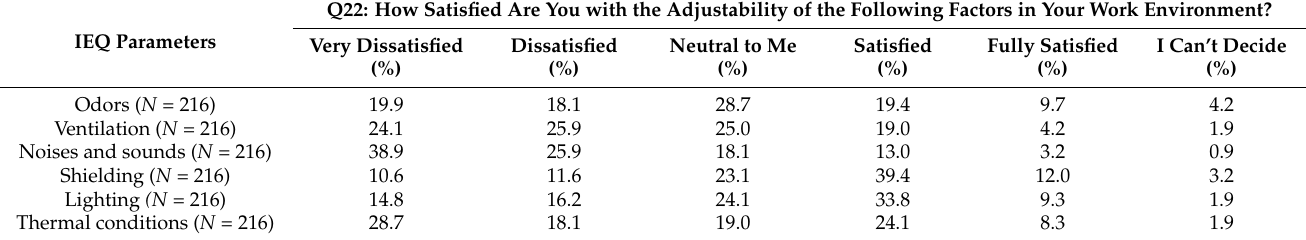
IEQ Parameters Table 1. Occupants’ satisfaction with the adjustability of IEQ parameters in their work environment.